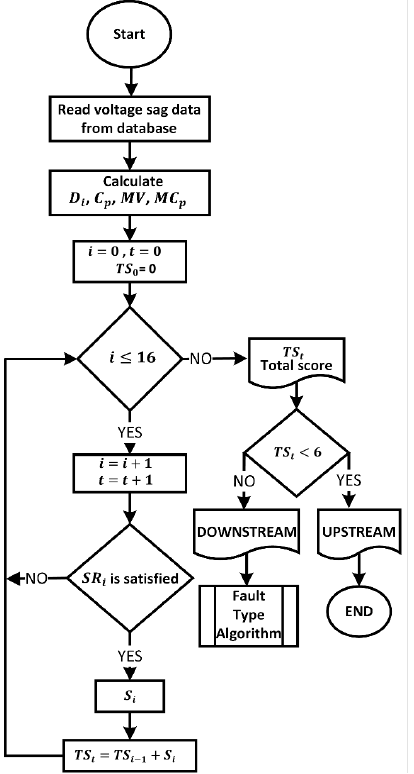
Figure 3. Flow diagram of the scoring algorithm.